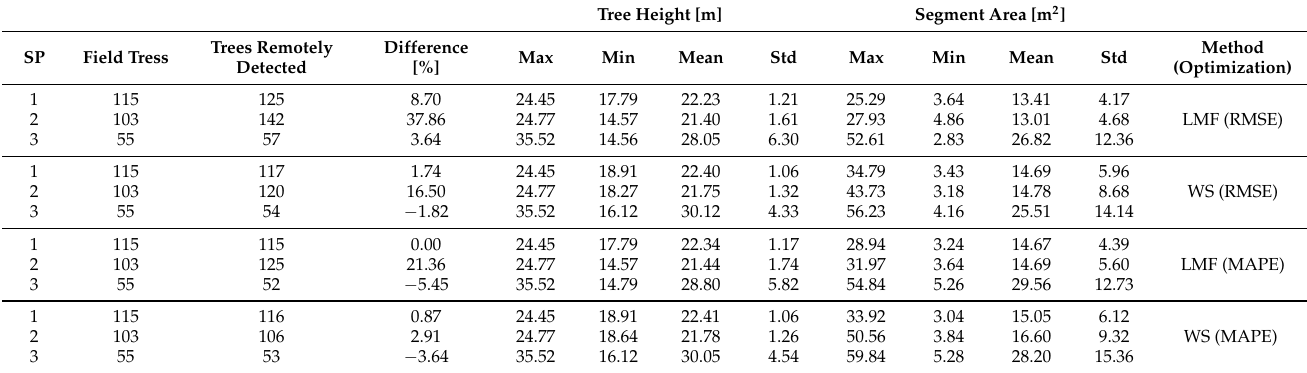
Table 4. Summary of basic statistics of resulting detected trees in case study analysis considering both methods (the Watershed (WS) method and the Local Maximum Filter (LMF) method) and variants of RMSE and MAPE optimization. Tree Height [m] Segment Area [m 2 ] SP Field Tress Trees Remotely Detected